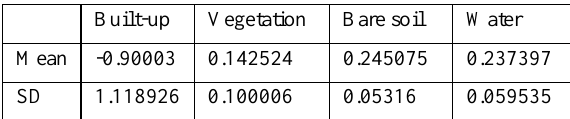
Figure 4. Index values (y-axis) for feature classes.